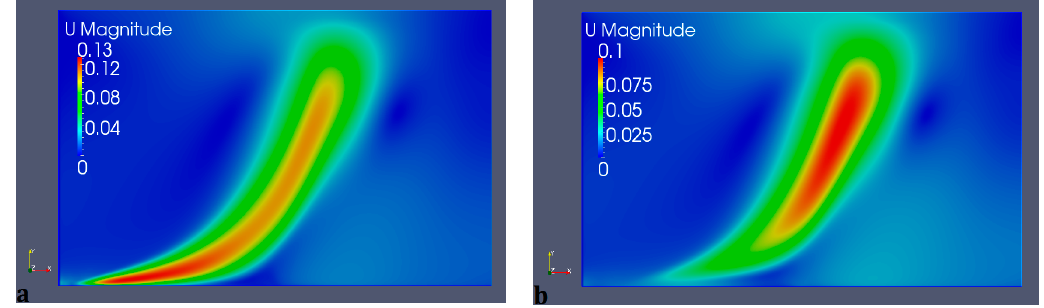
Figure 11. Velocity contour plots at two offset sections. ( a ) z/D = 1.818, ( b ) z/D = 3.636.